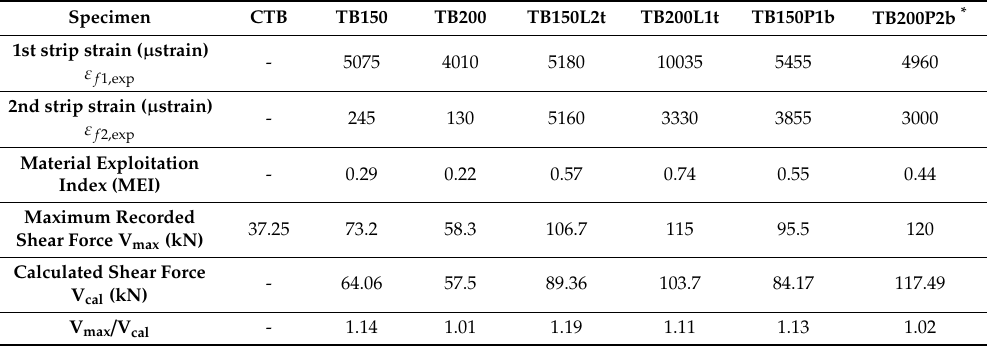
Table 6. Material exploitation index (MEI) and shear force